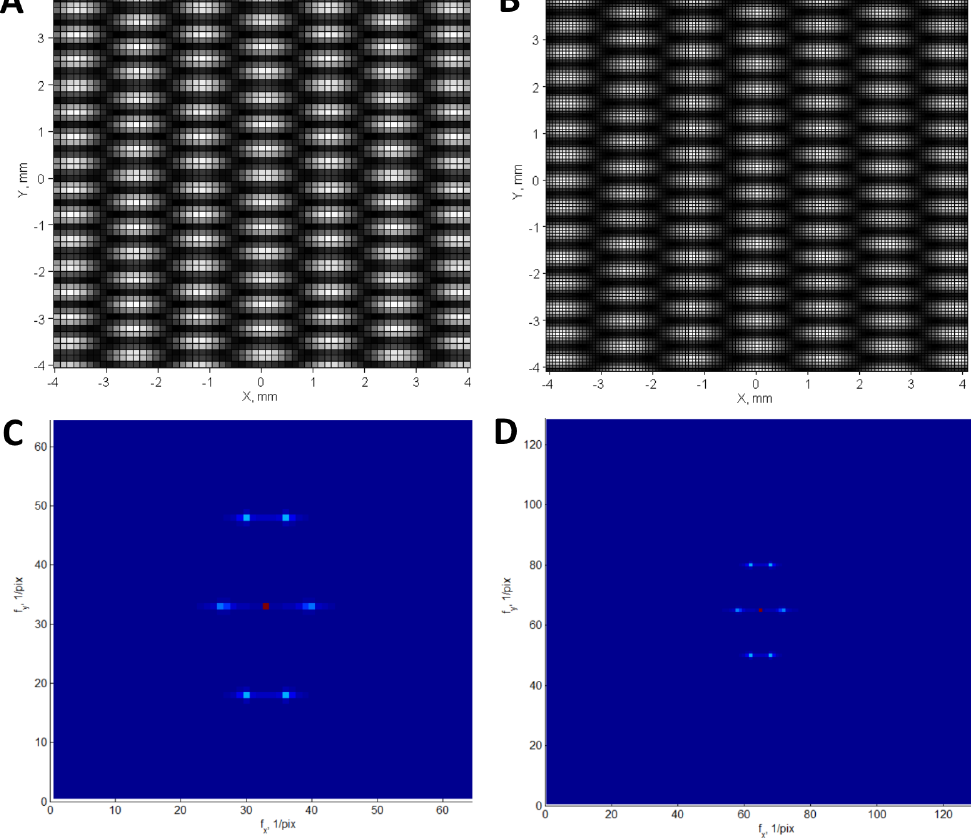
Figure 6. Sampling effect on the detected interference pattern: ( A ) interferogram detected with 128 µ m element pitch; ( B ) interferogram detected with 64 µ m element pitch; ( C ) Fourier spectrum for 128 µ m element pitch; ( D ) Fourier spectrum for 64 µ m element